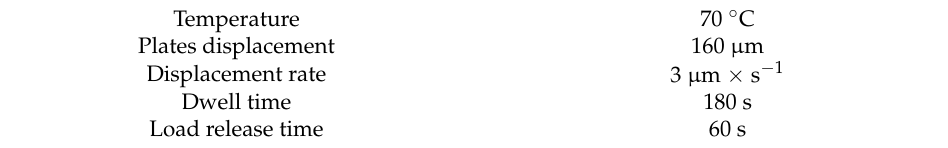
Table 2. Relevant parameters of the optimized lamination process.